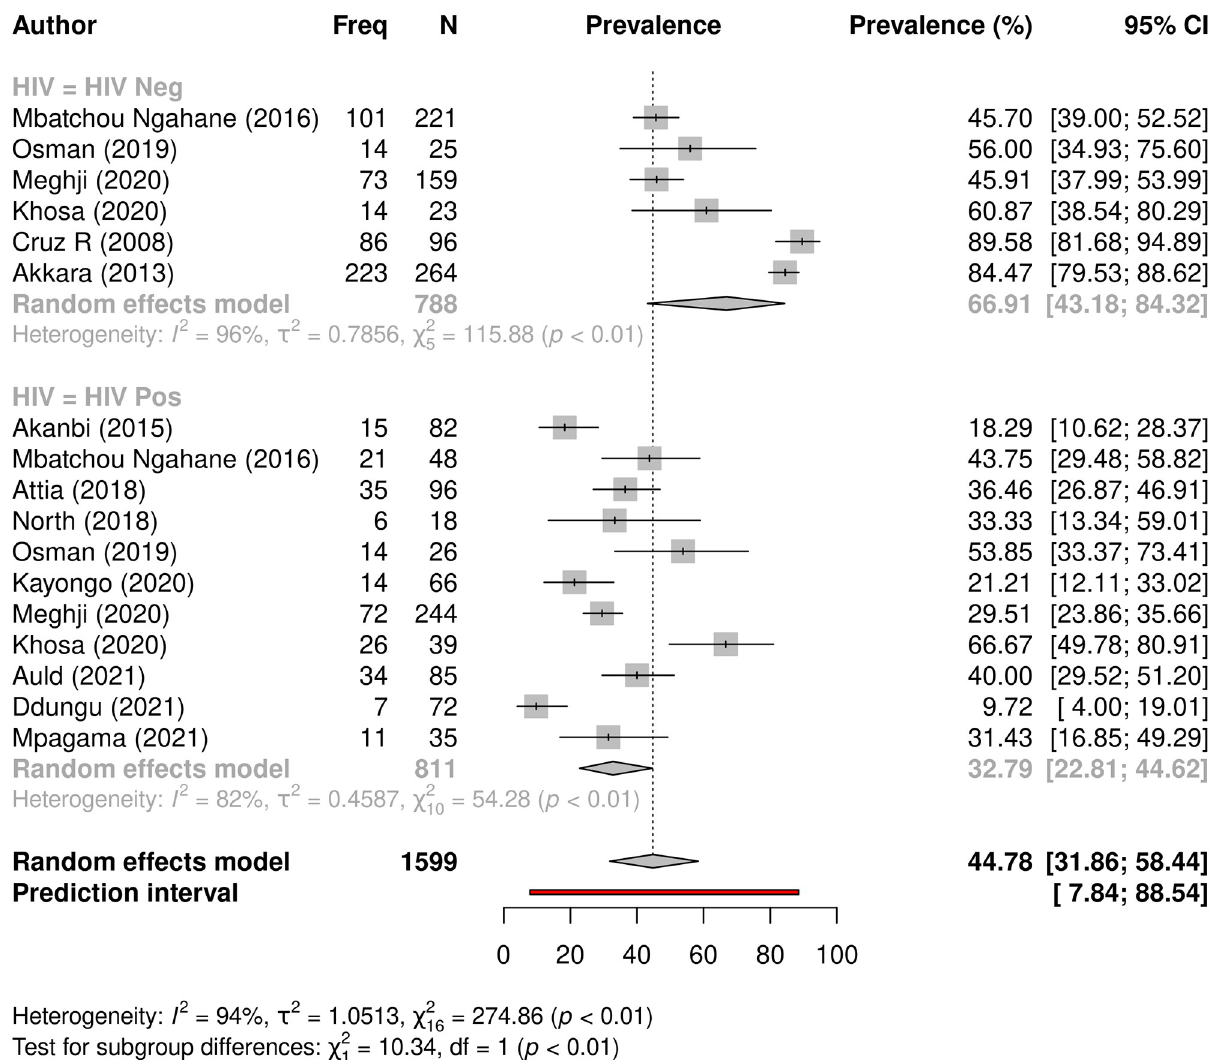
Fig 8. Prevalence of PTLD comparing HIV uninfected and HIV infected populations. A forest plot assessing relationship between HIV status and prevalence of PTLD (composite outcome) in studies which documented the HIV